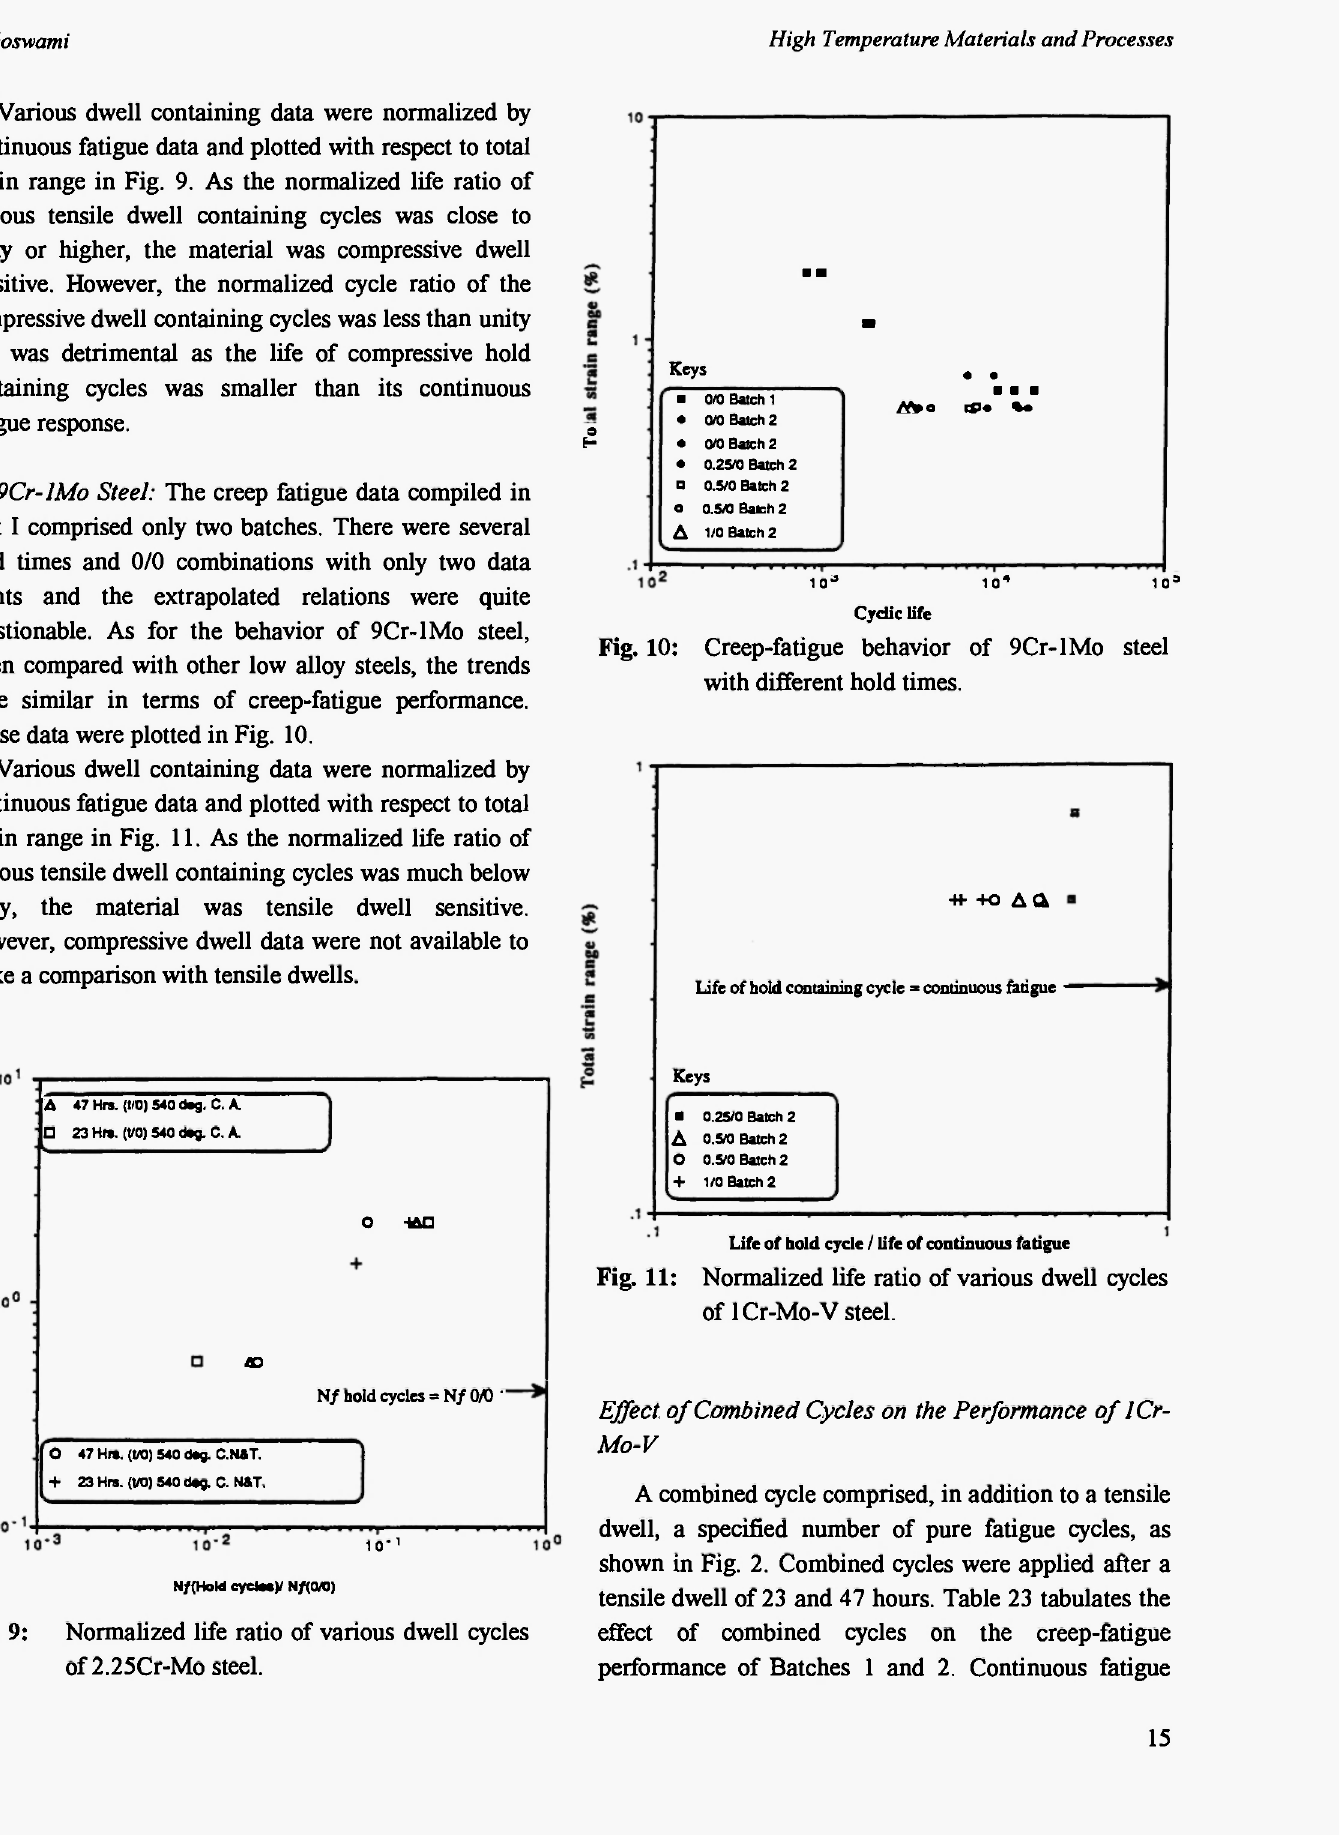
Effect of Combined Cycles on the Performance of lCr- Mo-V A combined cycle comprised, in addition to a tensile dwell, a specified number of pure fatigue cycles, as shown in Fig. 2. Combined cycles were applied after a tensile dwell of 23 and 47 hours. Table 23 tabulates the effect of combined cycles on the creep-fatigue performance of Batches 1 and 2. Continuous